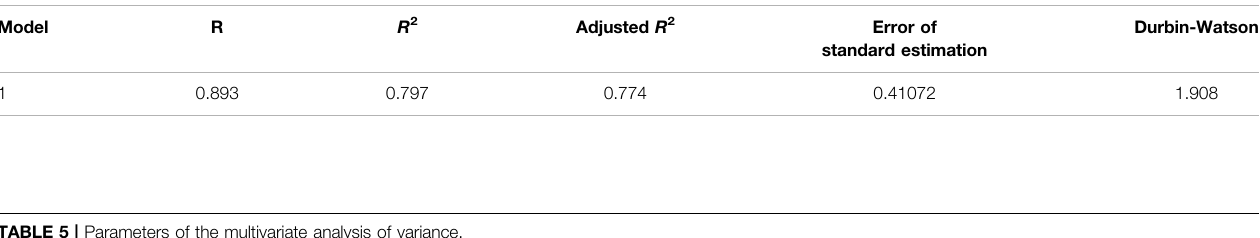
TABLE 4 | Fitting analysis parameters.